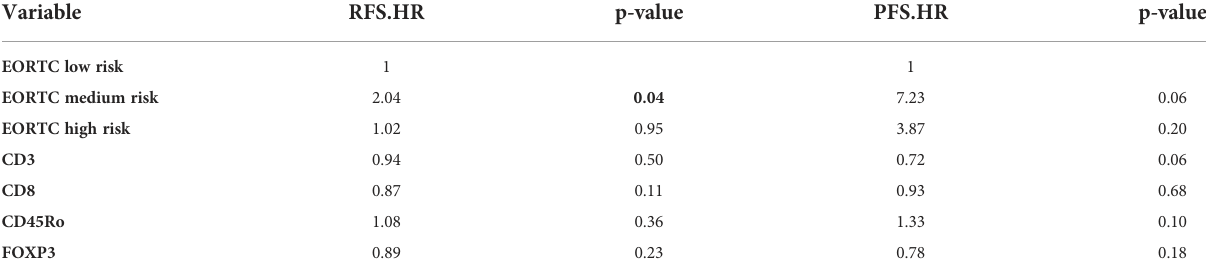
TABLE 3 Multivariable cox regression